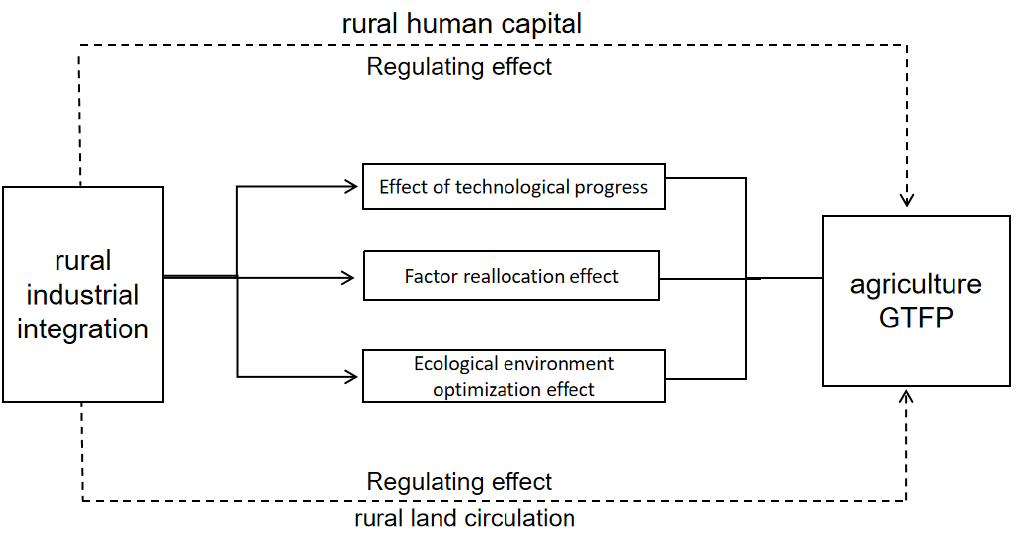
Figure 1. Frame diagram of the influence mechanism of rural industrial integration on agricultural GTFP.